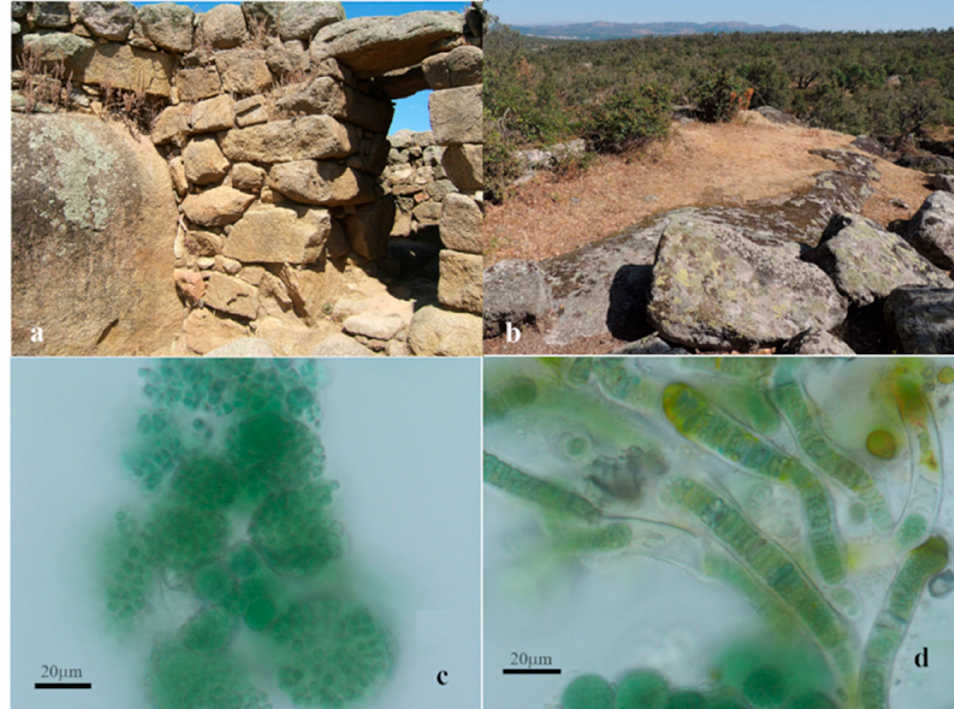
Figure 9. Biocolonisers of granite: (a) Parmelia conspersa (green greyish) and black patina; (b) Lecanora sulfurea (green yellowish), Tephormela atra (grey), and Parmelia loxodes (dark brown on the horizontal surface); (c) Chroococcidiopsis sp.-like colonies; (d) Calothrix sp.-like filaments.